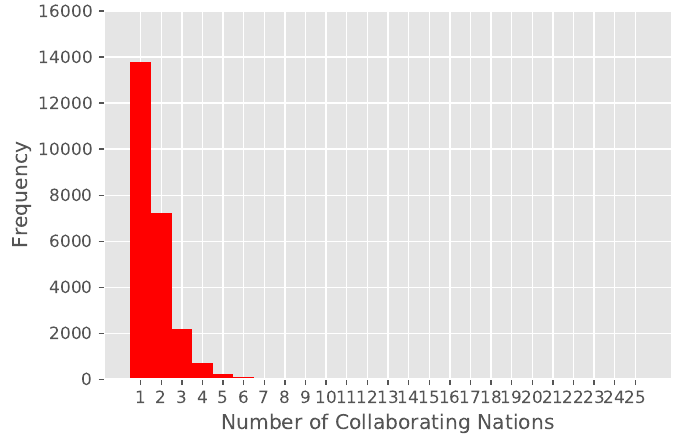
Figure 5. A histogram of the number of different nations represented on papers published in MDPI journals between 1996 and 2018 which include at least one author from a nation in the upper-middle-income